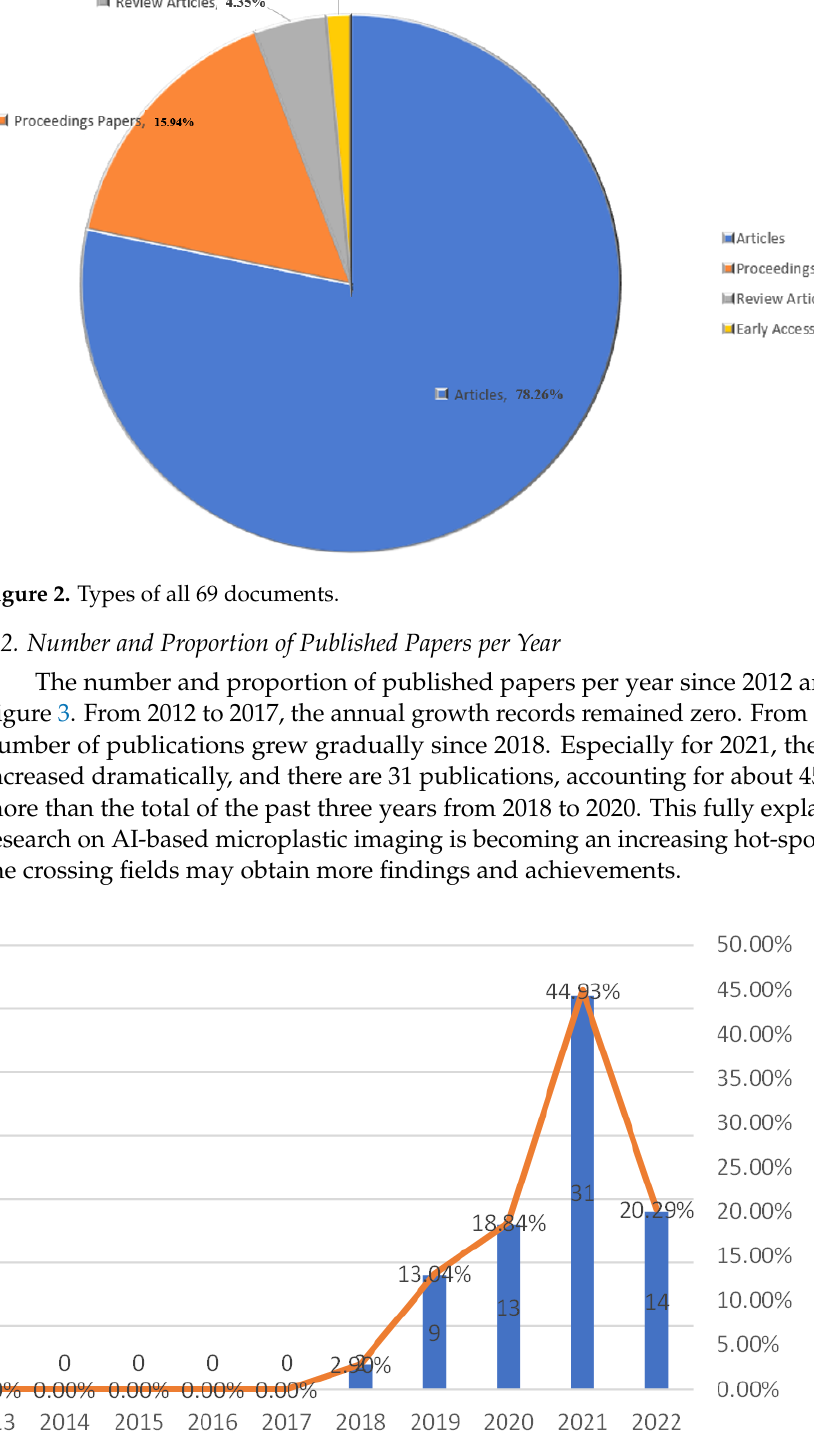
Figure 4. Top 10 hot research areas (generated using Web of Science on data). 3.4. High Frequency Keywords and Density Mapping Based on the statistics about the keywords from 2018 to 2022 among 69 publications, there were 357 keywords, where 6 keywords with more than 10 times in Figure 5. Micro- plastics (42), machine learning (29), deep learning (17), identification (13), pollution (13), and classification (12) are the top sic keywords in the research high frequency themes in Figure 5, which means artificial intelligence technologies have already been engaged in the research direction of microplastic-imaging technologies to a very deep level.